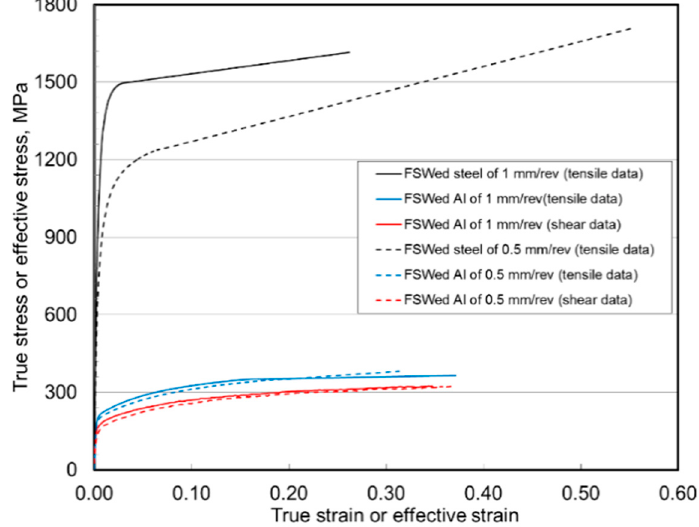
Figure 19. True and effective stress–strain curves of constituents in the stir zone obtained from tensile and shear test.